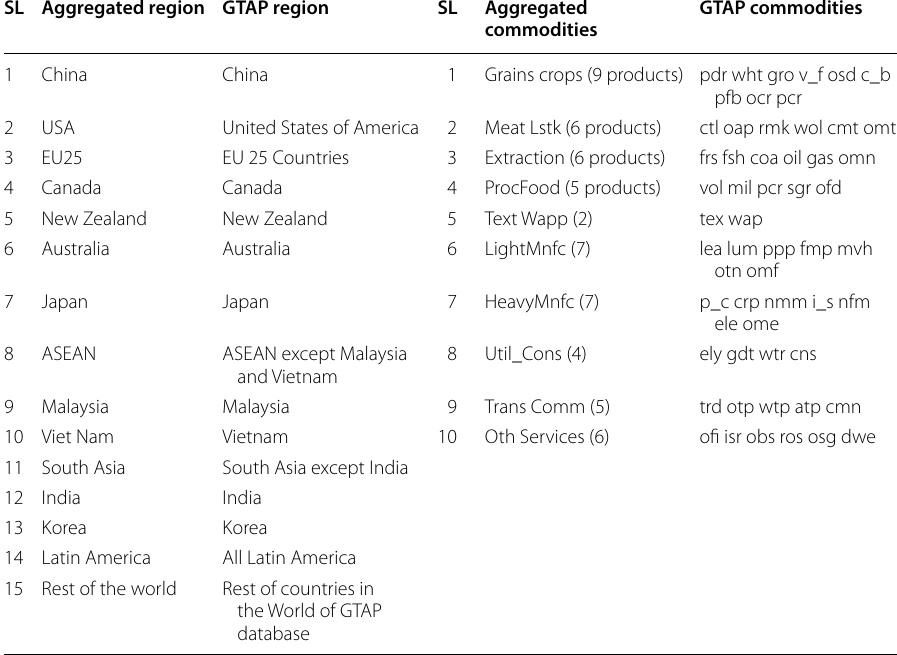
Table 13 Regional and commodity aggregation of GTAP database. Source: GTAP version 9 SL Aggregated region GTAP region SL Aggregated